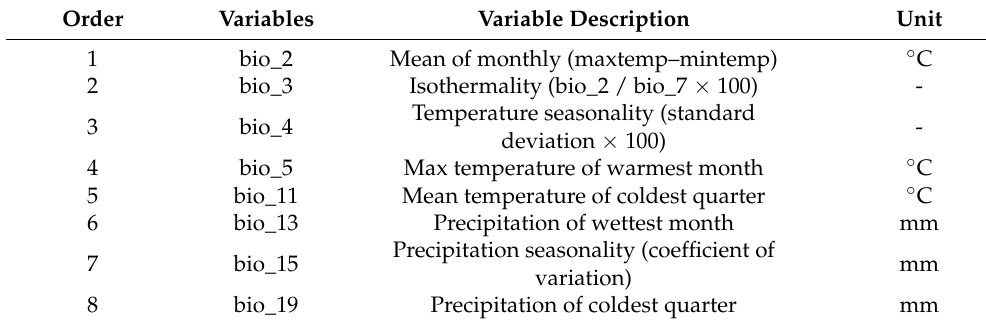
Table 4. Description of selected